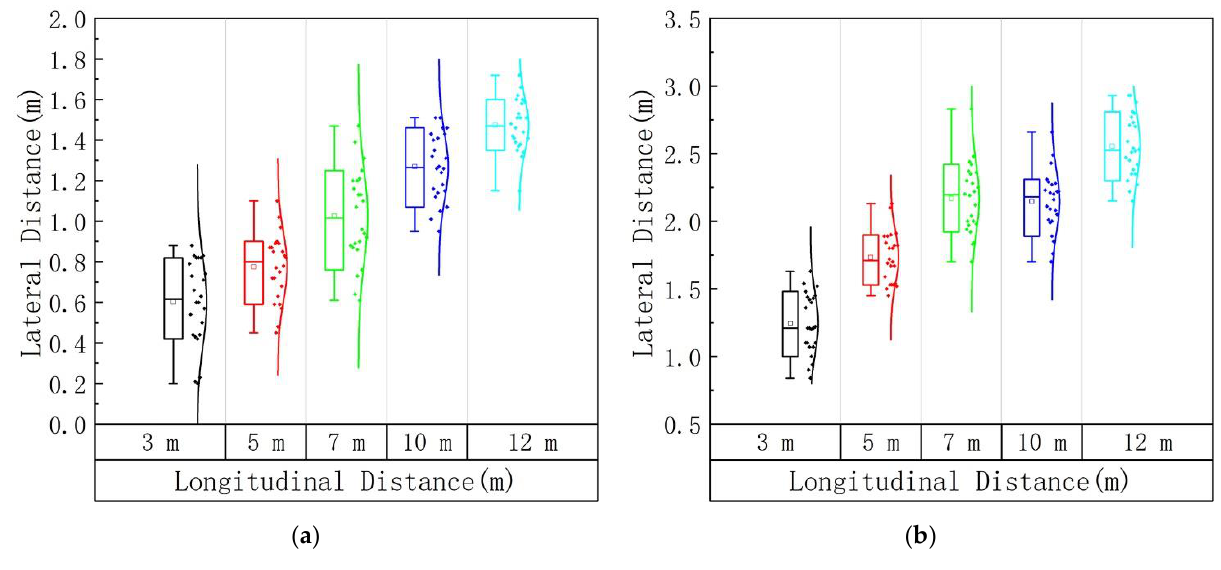
Figure 9. Lateral apoapsis under different longitudinal distances: ( a ) DGIG; ( b ) IGAG. Table 2. Difference analysis results regarding age and lateral apoapsis under different longitudinal distances.